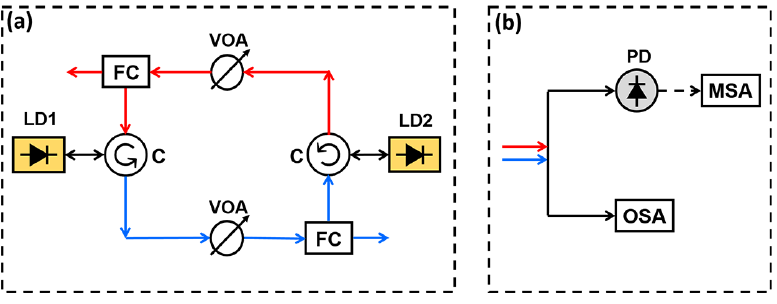
Figure 5. Schematic diagram of ( a ) a mutually delay-coupled laser system and ( b ) a detection system. LD1, laser diode 1; LD2, laser diode 2; FC, fiber coupler; C, circulator; VOA, variable optical attenuator; PD, photodetector; OSA, optical spectrum analyzer; and MSA, microwave spectrum